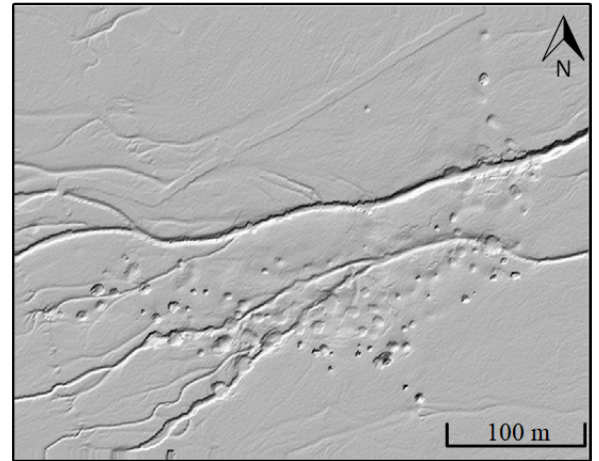
Figure 4. Airborne laser scan of an alluvial fan ( 31 ◦ 20 (cid:48) N, 35 ◦ 25 (cid:48) E).